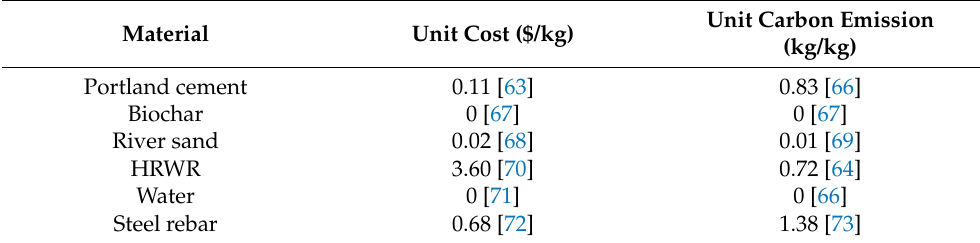
Table 4. Inventory data of unit material cost and unit carbon emission.